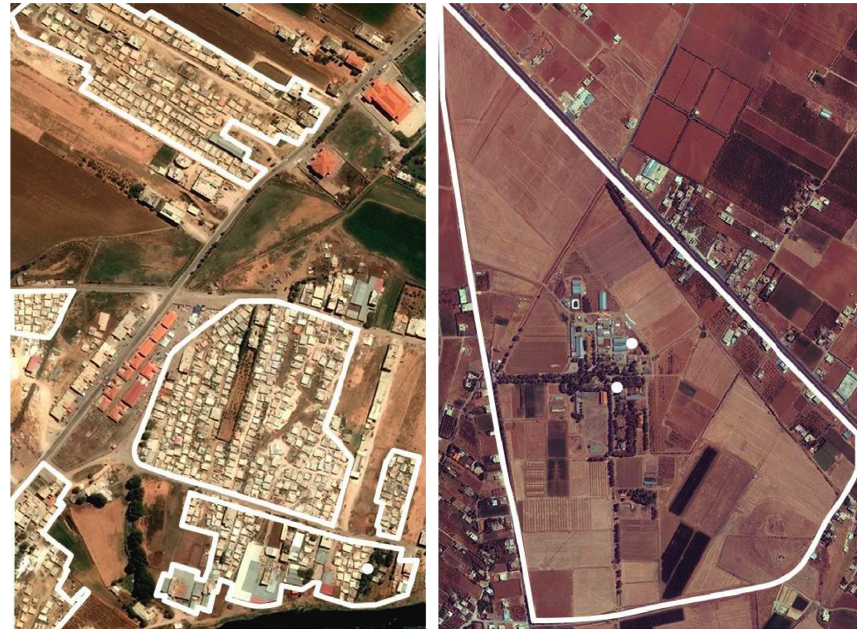
Figure 4: Bekaa Valley transpiration maps. Table 1: Calculation of remote sense and Bowen ratio.